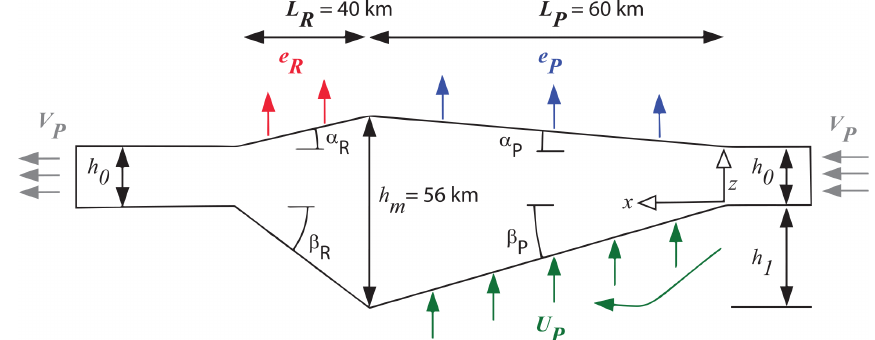
Figure 5. Kinematic model of the Northern Apennines as an orogenic wedge with internal deformation driven by frontal and basal accretion and surface erosion. Mass is balanced to maintain a steady size, and internal deformation is calculated to be consistent with boundary conditions.